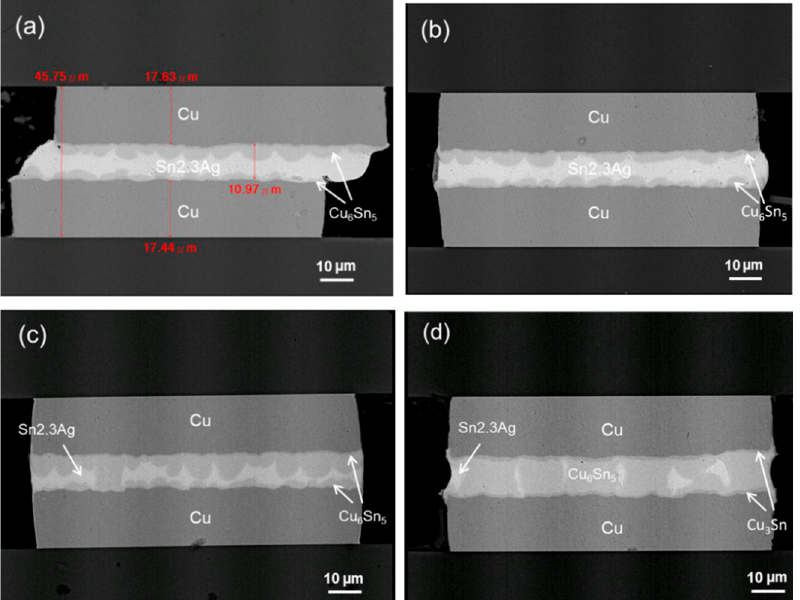
Figure 3. Cross-sectional SEM BEIs of the IMC-bridging Cu/solder/Cu microbumps reflowed for ( a ) 0 min, ( b ) 5 min, ( c ) 10 min, and ( d ) 30 min. Arrows designate the IMCs.